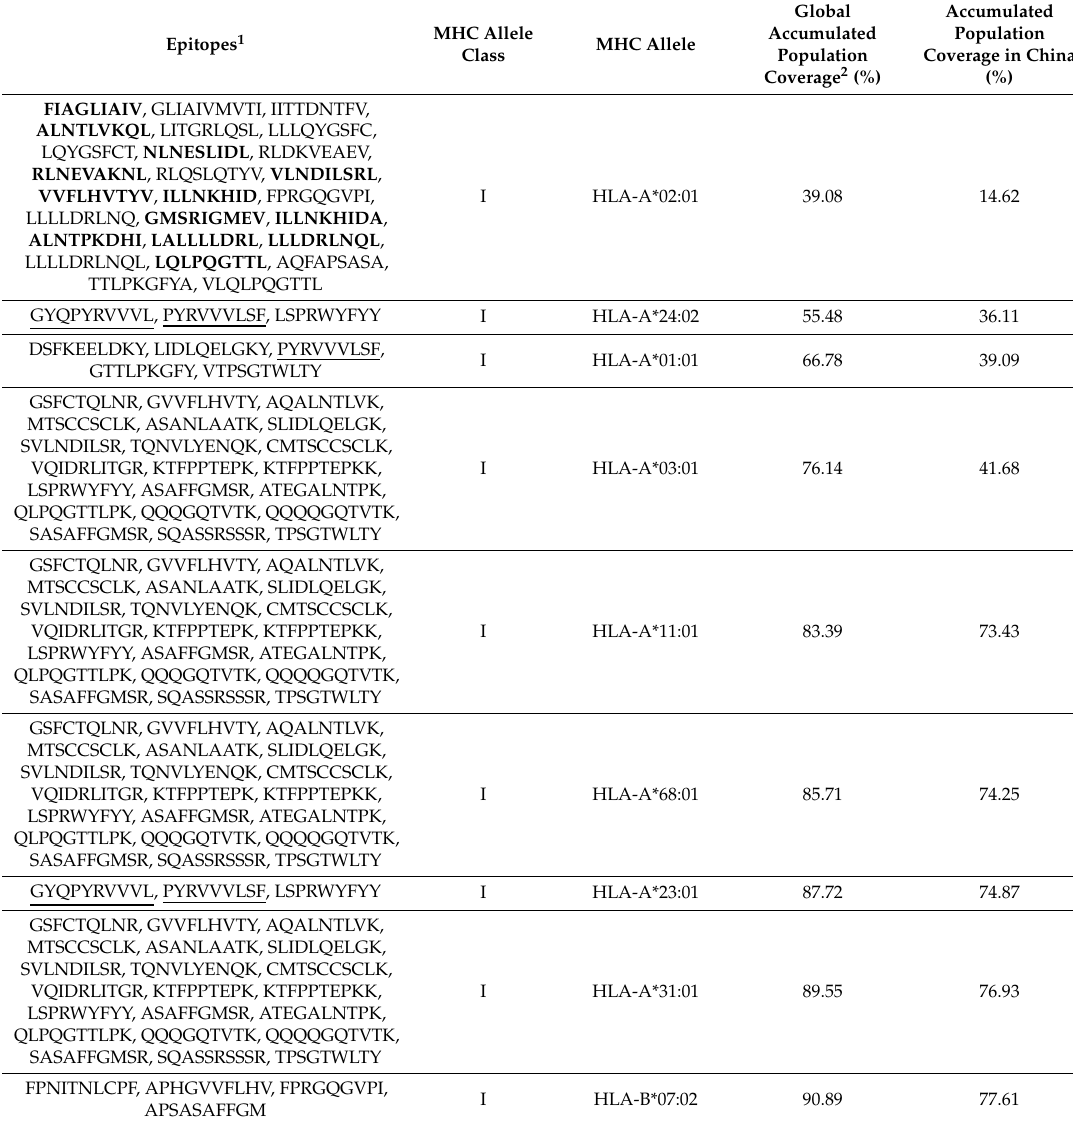
Table 3. Set of the SARS-CoV-derived spike (S) and nucleocapsid (N) protein T cell epitopes (obtained from positive MHC binding assays) that are identical in SARS-CoV-2 and that maximize estimated population coverage globally (87 distinct